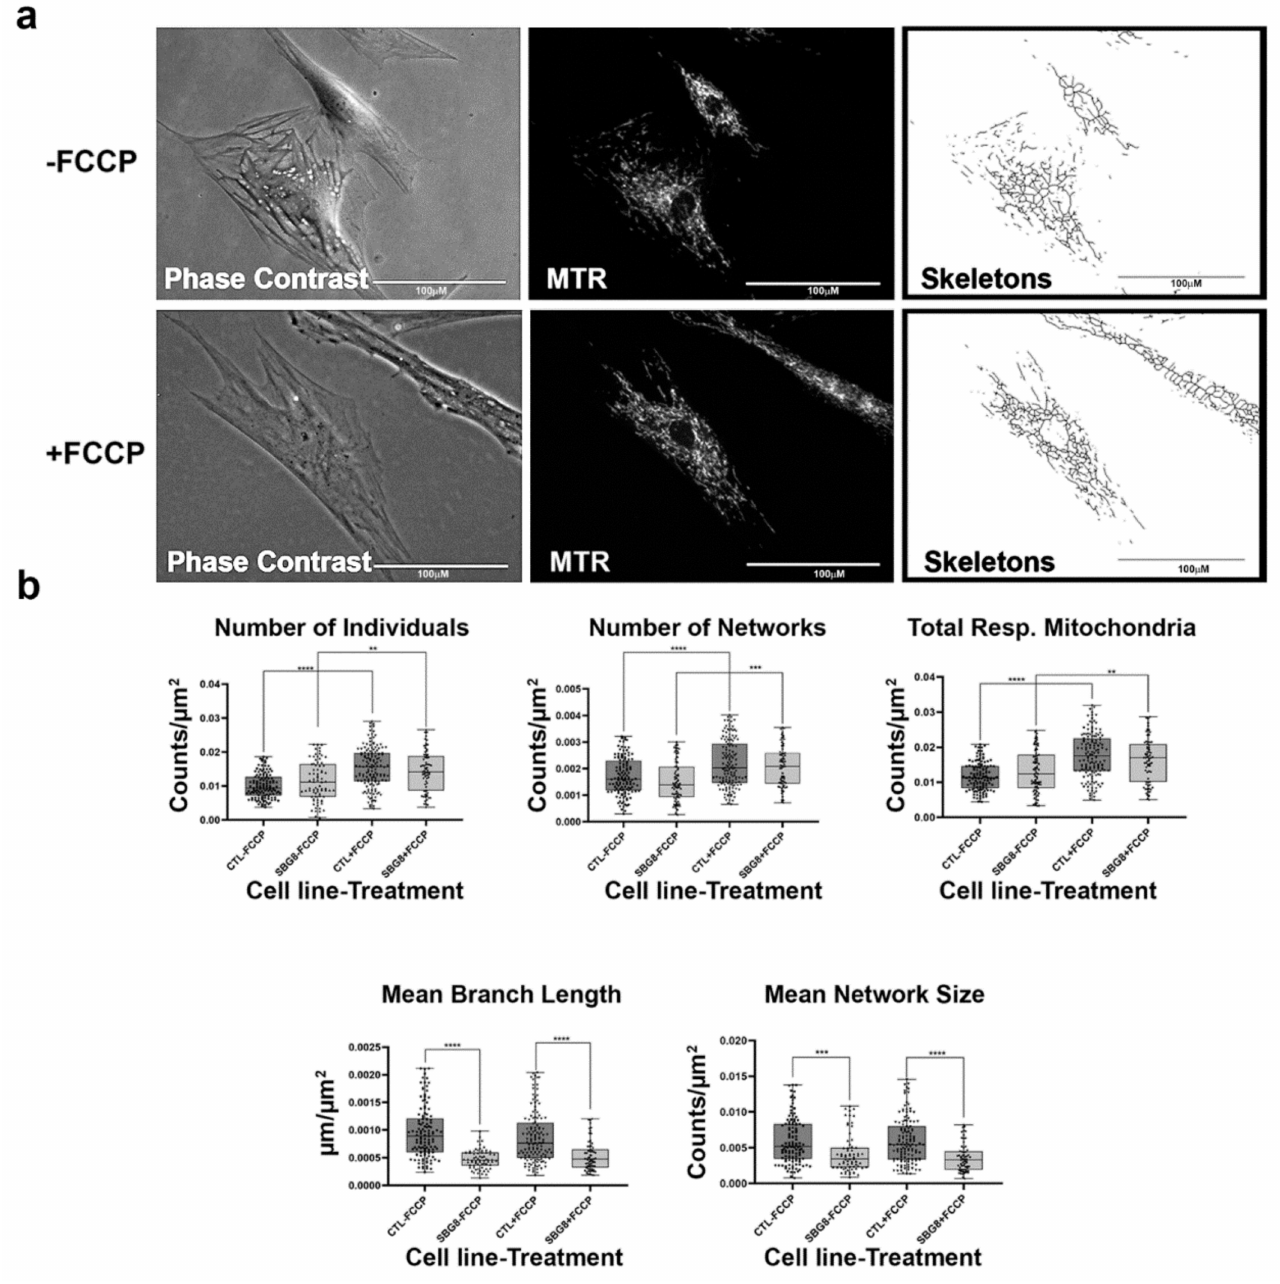
Figure 10. Mitochondrial morphology of SBG8 fibroblast in the absence and presence of FCCP. ( a ) Representative images of SBG8 fibroblast cell lines stained with MTR. The top images are phase contrast, RFP, and skeletonized images of SBG8 fibroblast cell lines without FCCP treatment. The bottom images are phase contrast, RFP, and skeletonized images of SBG8 fibroblasts with FCCP treatment. ( b ) SBG8 fibroblasts have significantly shorter branch lengths and fewer branches within their networks. All data are representative of 10–14 images taken from three independent dishes per treatment group. The bars represent minimum and maximal values, and each black dot represent different data points. **** p < 0.0001, *** p < 0.001, ** p < 0.01 Scale bar = 100 µ